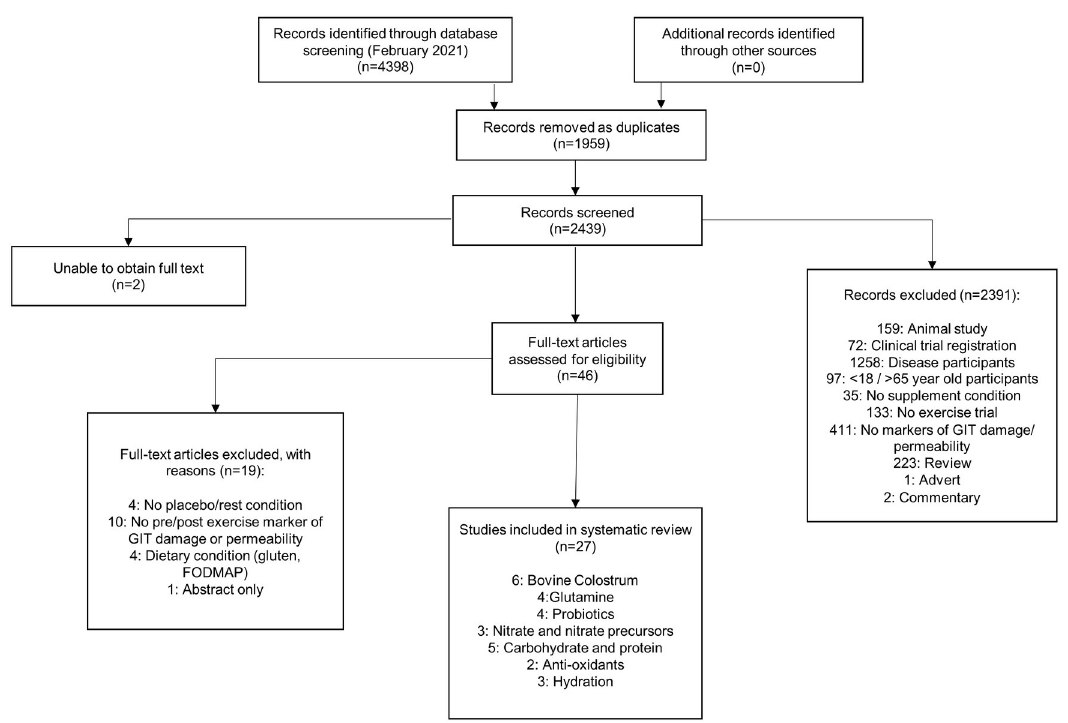
Fig 1. Flow chart for selected studies according to the PRISMA